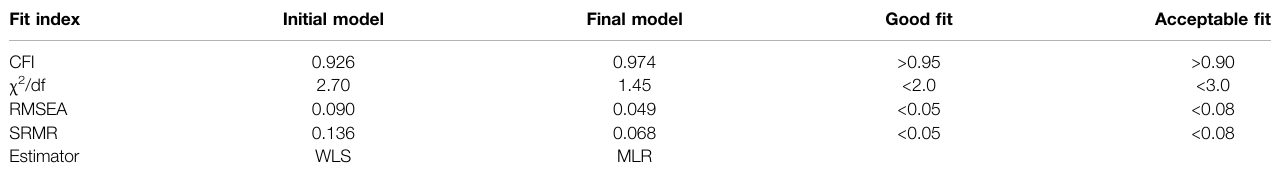
TABLE 1 | Recommended and actual fi t indices for initial and pruned path models.